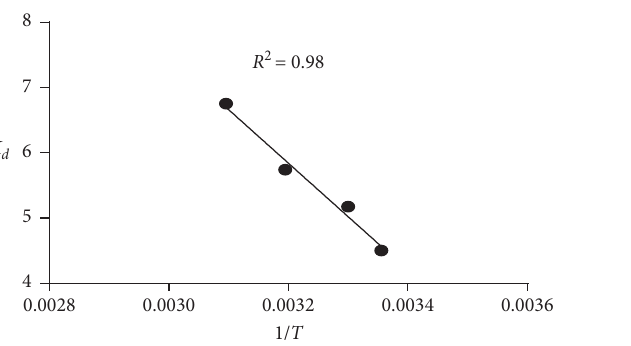
Figure 11: Variation of partition coefficient K ° C, adsorbent amount (ASP): 0.2g, initial BG d as a function of 1/ T . Temperature range: 20–50 dye concentration: 50 mg/L, and V : 200ml. Table 6: Thermodynamic parameters of the adsorption process of BG dye onto ASP at various